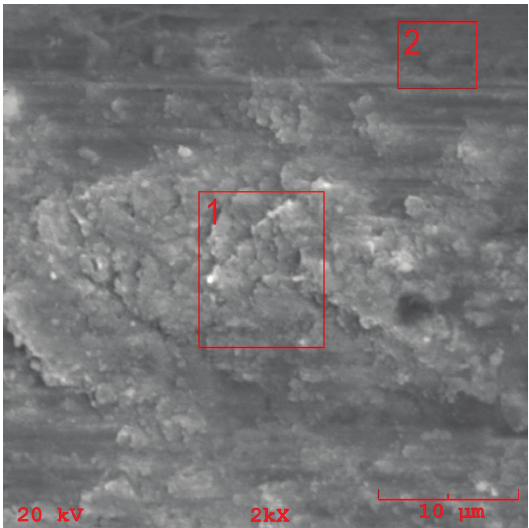
Figure 11. SEM micrograph referring to the wear track of AISI H13 sample without treatment, showing the regions analyzed by